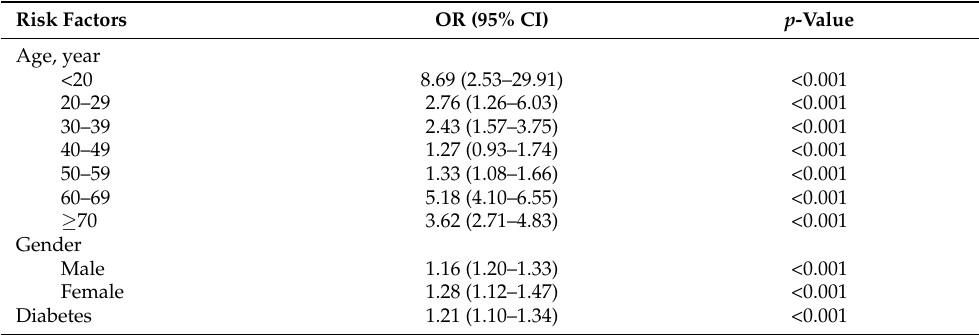
Table 7. Korean diabetes COVID-19 scores in the KCDC COVID-19 dataset (3496 COVID-19 cases, n = 20,976, AUC= 0.52).